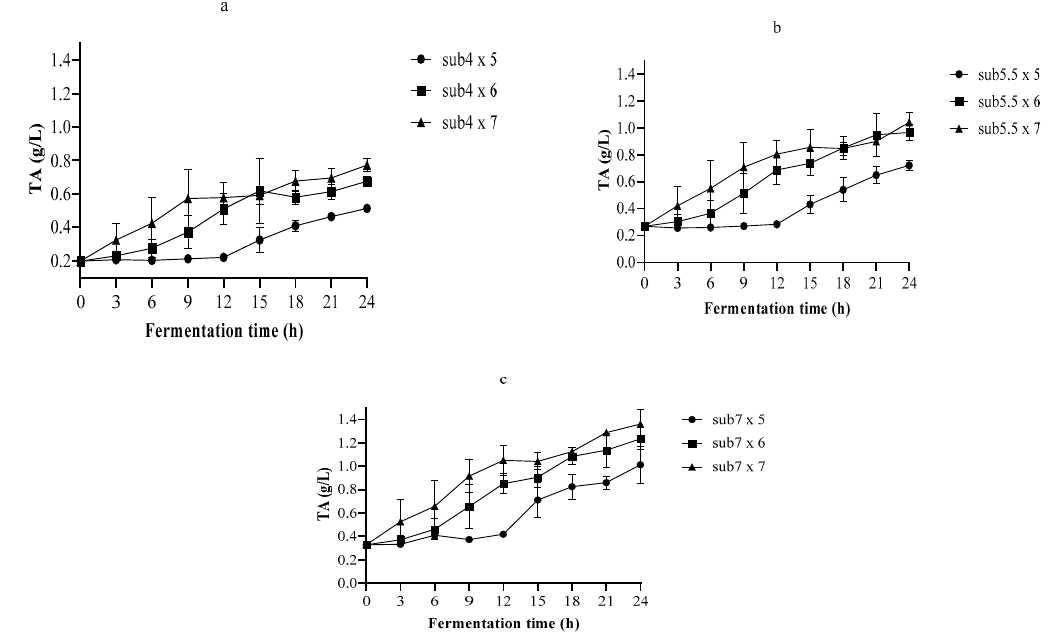
Figure 3. Titratable acidity changes during fermentation of ( a ) 4% w/v , ( b ) 5.5% w/v , and ( c ) 7% w/v substrate with Lactobacillus plantarum A6; sub4 × 5, 4% w/v substrate inoculated with 5 log cfu/mL; sub4 × 6, 4% w/v substrate inoculated with 6 log cfu/mL; sub4 × 7, 4% w/v substrate inoculated with 7 log cfu/mL; sub5.5 × 5, 5.5% w/v substrate inoculated with 5 log cfu/mL; sub5.5 × 6, 5.5% w/v substrate inoculated with 6 log cfu/mL; sub5.5 × 7, 5.5% w/v substrate inoculated with 7 log cfu/mL; sub7 × 5, 7% w/v substrate inoculated with 5 log cfu/mL; sub7 × 6, 7% w/v substrate inoculated with 6 log cfu/mL; sub7 × 7, 7% w/v substrate inoculated with 7 log cfu/mL.